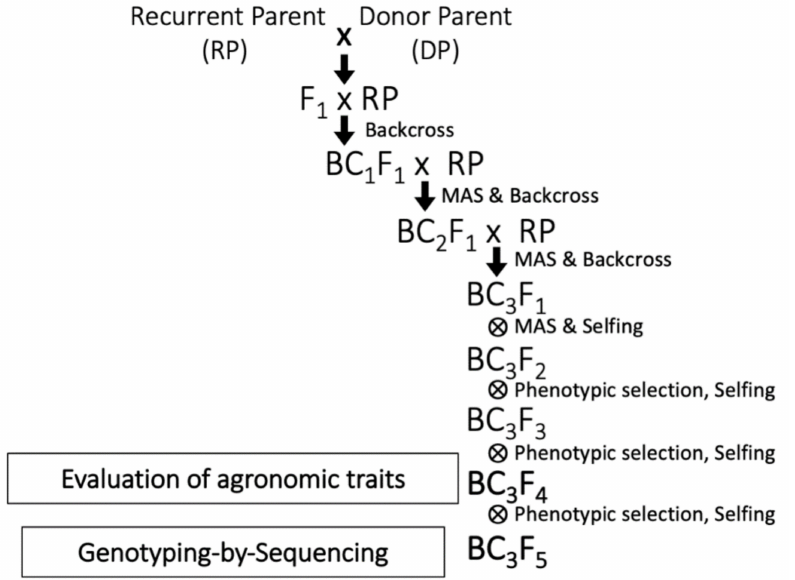
Figure 10. Marker-assisted backcross breeding scheme of Gn1a and WFP introgression in NERICA and WAB rice cultivars.